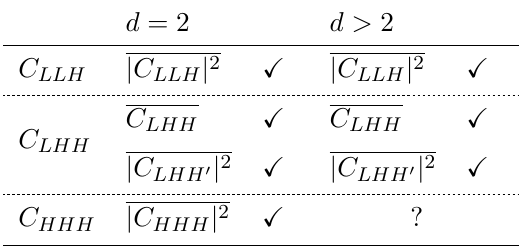
Table 1 . Current status of the various known CFT asymptotic formulas for either light (L) or heavy (H) operators. It remains to constrain asymptotic formulas involving C HHH in d > 2 , which is one of the goals of the present